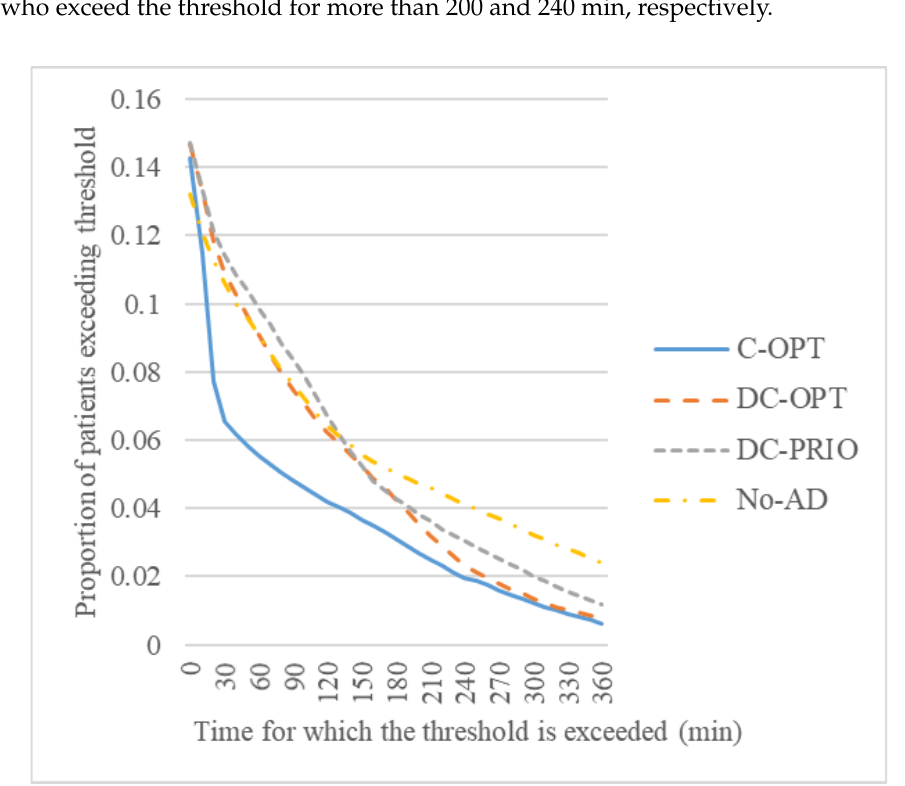
Figure 4. Box plot of average tardiness of patients.